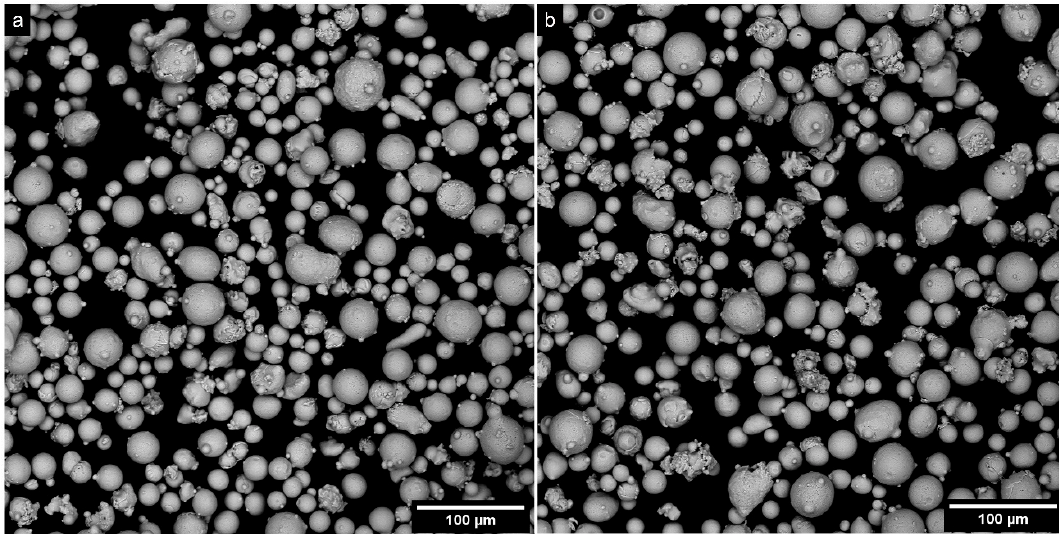
Figure 5. Powder morphology of batches ( a ) A and ( b ) B.